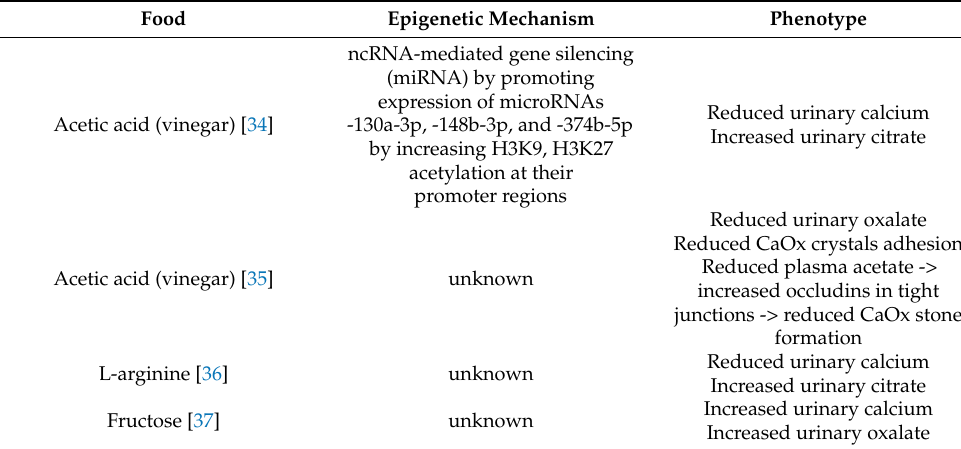
Table 1. Schematic summary of the relationship between food compounds and pro or antilithogenic urinary phenotypes mediated by proved or hypothesized epigenetic mechanisms.